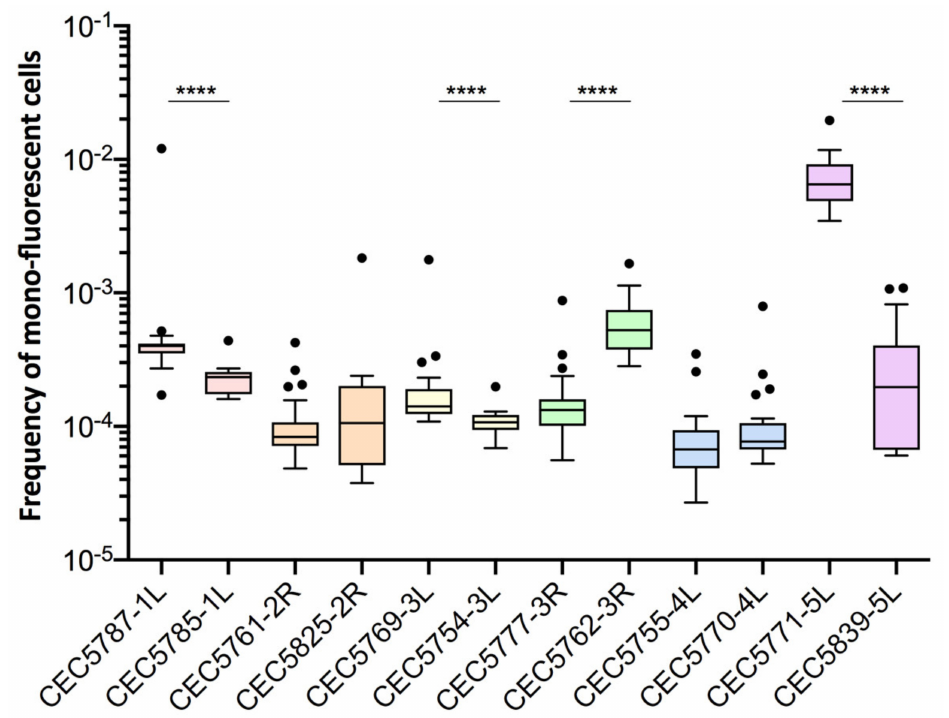
Figure 4. Basal LOH frequencies of two independently constructed strains. Frequency of mono- fluorescence and LOH frequency in YPD represented by box plot and whiskers (Tukey) were assessed by fluctuation analysis ( n = 24). Frequencies of independently constructed strains were compared using the Mann–Whitney test, p < 0.05 (**** p <